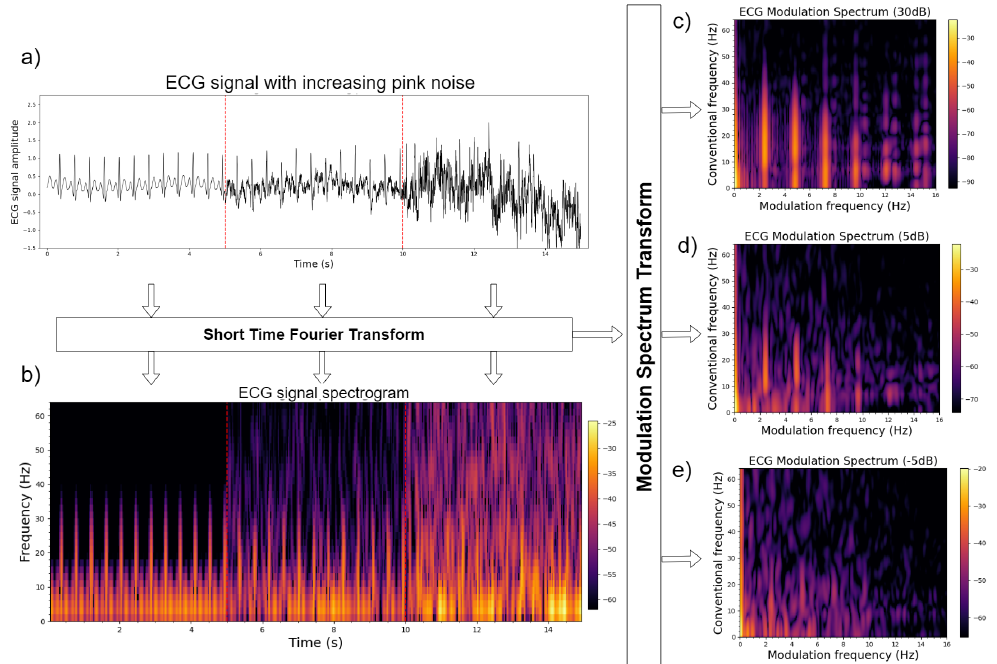
Figure 2. Plots of ( a ) three snippets of synthetic ECG corrupted by noise at SNR levels of 30 dB, 5 dB, and − 5 dB; ( b ) their respective time–frequency plots; and ( c – e ) the modulation spectrograms for the three